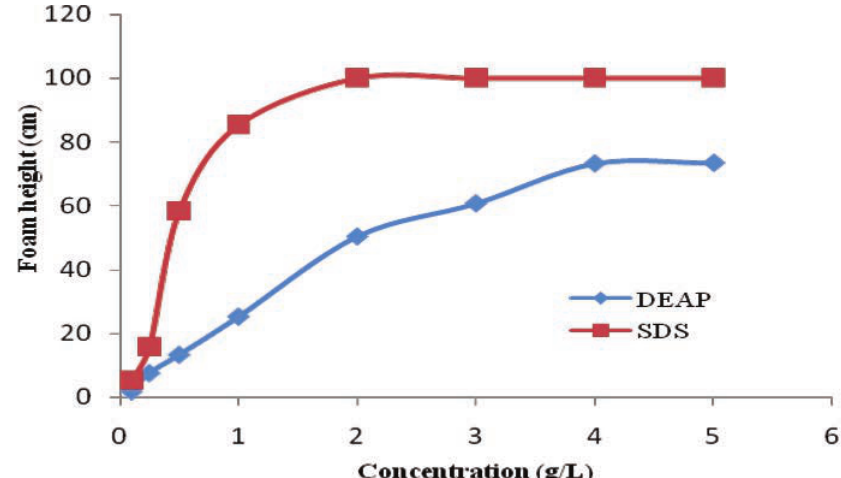
Figure 6. Effect of concentration of foam height. DEAP = Sodium phosphate-hydroxy ethanolamide.